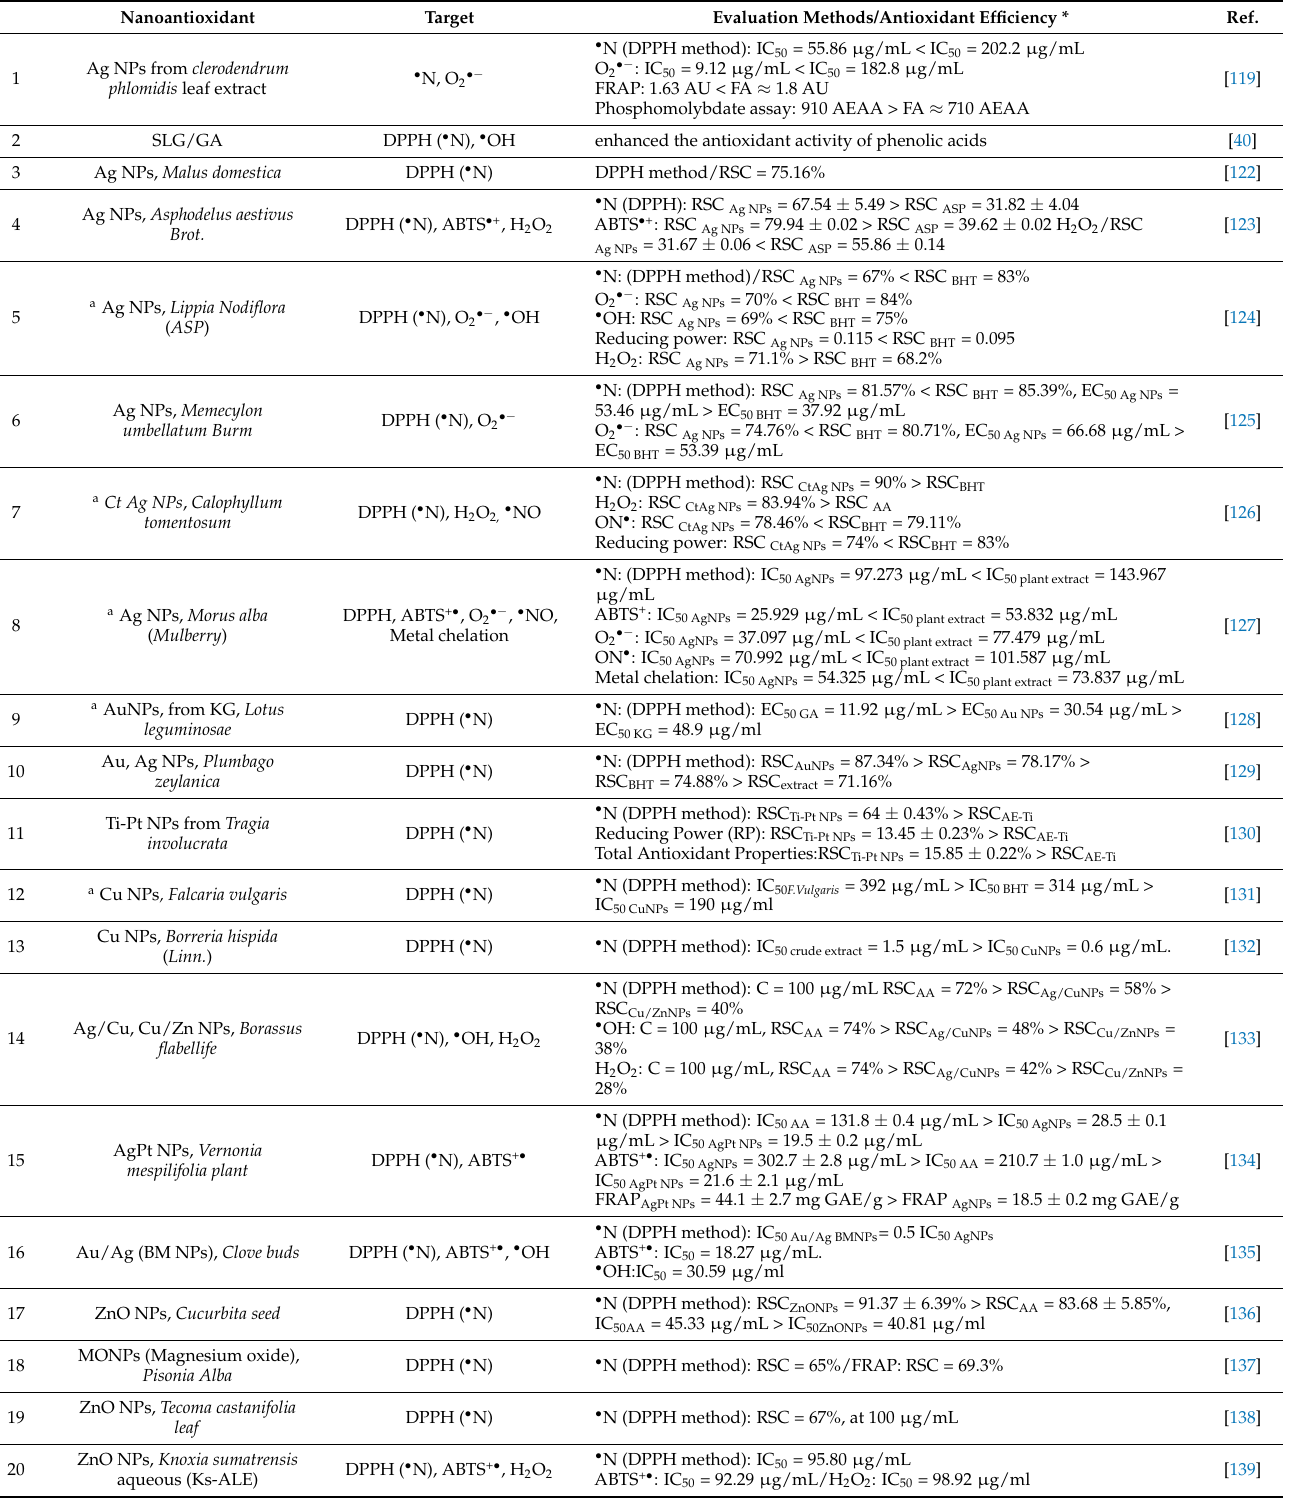
Table 2. List of engineered nanoantioxidants synthesized directly from natural